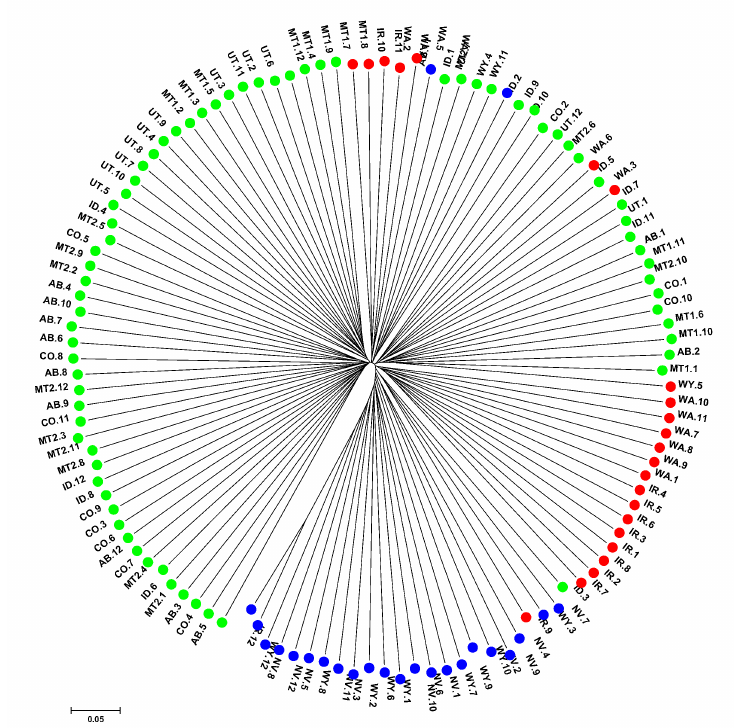
Figure 3. Genetic relationships of the 119 samples of the 10 northern wheatgrass accessions as revealed by neighbor-joining clustering with the 5659 SNP markers. Each sample is numbered after its accession label (see Table 1) with a dot. Each node for a sample is represented by a colored circle. Red, green, and blue represent Clusters 1, 2 and 3 inferred from the STRUCTURE analysis (see Figure 2A), respectively.